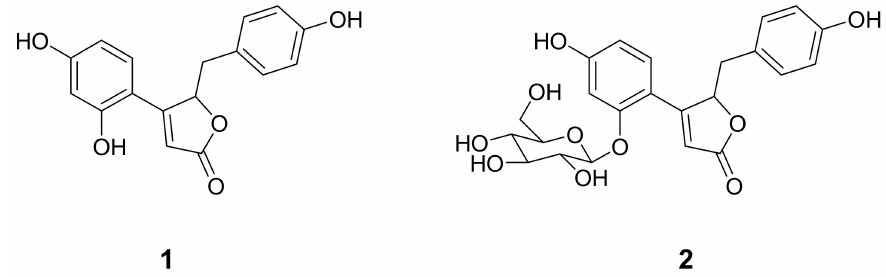
Figure 1. Structures of tyrosinase inhibitory compounds ( 1 and 2 ) from A. fruticosa